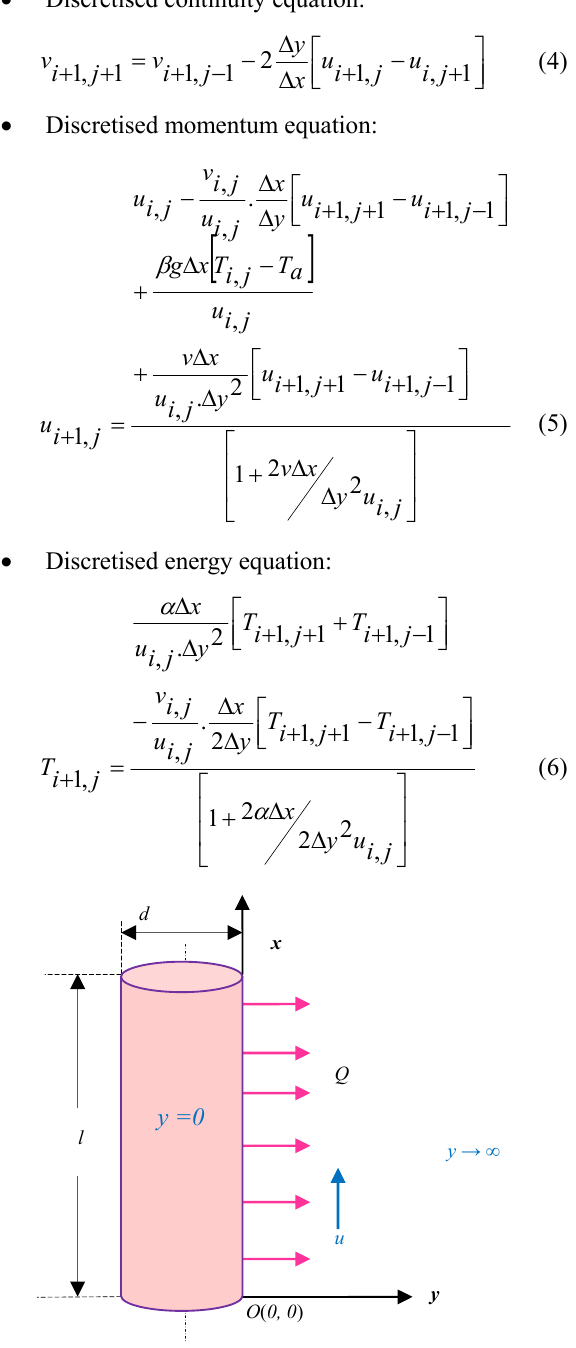
Figure 1. Two-dimensional coordinate system model ( x , y ) in the area across a cylindrical tube positioned in the vertical